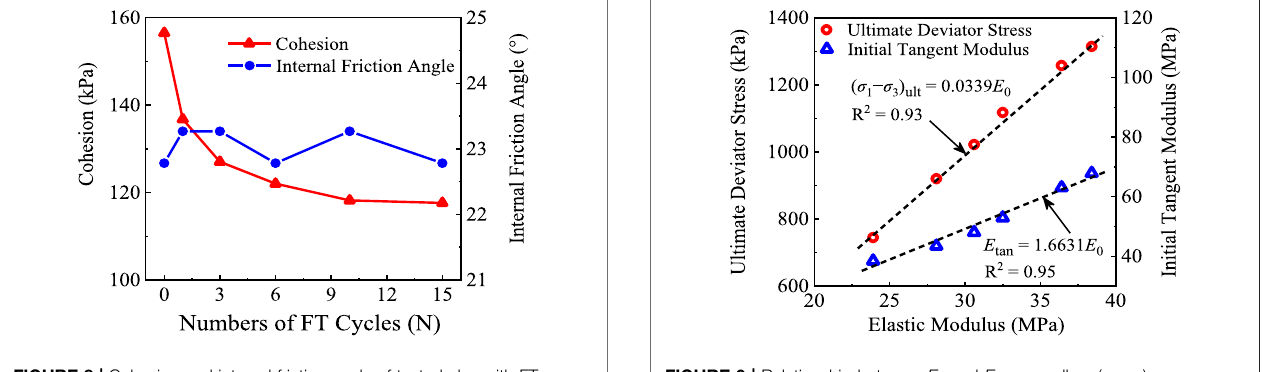
FIGURE 8 | Cohesion and internal friction angle of tested clay with FT cycles.